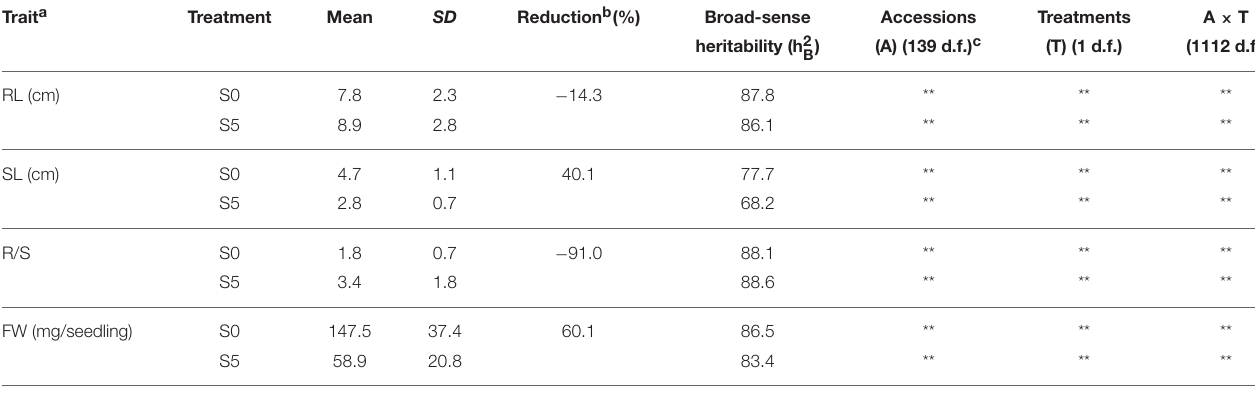
TABLE 1 | Mean values and broad-sense heritability of seedling traits observed under normal (S0) and water stress (S5) conditions. Trait a